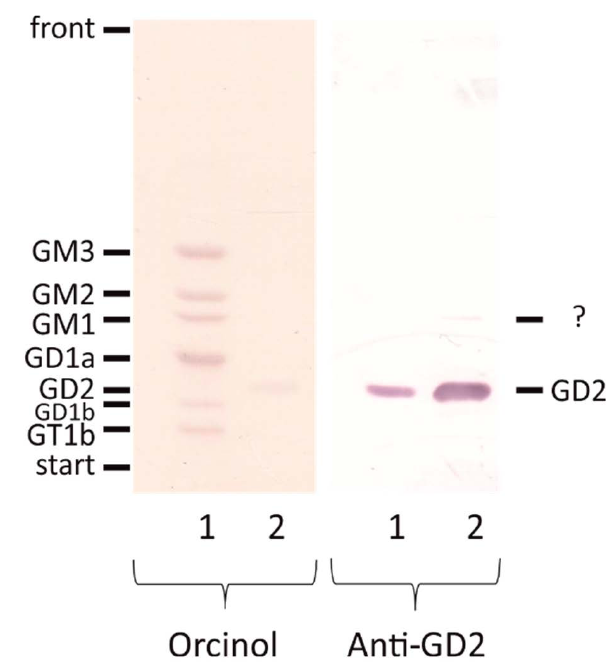
Figure 2. Validation of the anti-GD2 antibody used for flow cytometry. A ganglioside standard containing purified bovine brain cortex gangliosides and gangliosides GM3 and GM2 were loaded on lane 1 and standard ganglioside GD2 was loaded on lane 2. Gangliosides were separated by thin layer chromatography and subjected to immunostaining using the anti-GD2 antibody (right). Subsequently, staining was removed, and all gangliosides were stained with orcinol (left). The anti-GD2 antibody does not recognize any of the indicated gangliosides (GM3, GM2, GM1, GD1a, GD1b, GT1b) besides GD2. Although not visible by orcinol staining, GD2 is present in the ganglioside extract of bovine brain cortex. However, the anti-GD2 antibody recognizes an unknown compound, which is present in the GD2-standard (band marked with